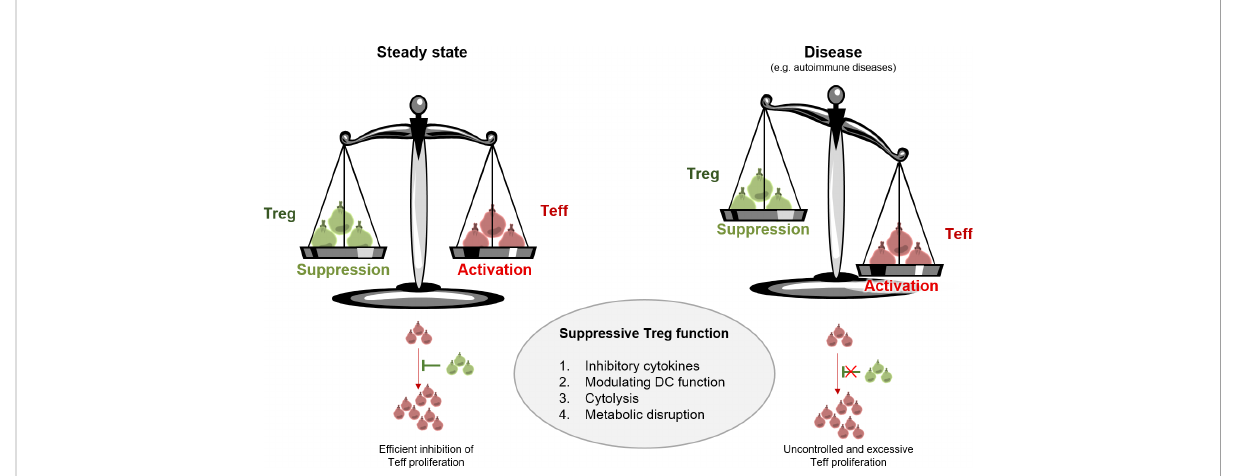
FIGURE 1 Treg function in steady state versus disease. Treg are active mediators of peripheral tolerance and protect us from excessive immune responses including autoimmunity. Treg maintain homeostasis mainly through four modes of action: 1. inhibitory cytokine production, 2. modulating DC function, 3. cytolysis, and 4. metabolic disruption. Aberrant Treg function results in disturbance of immune homeostasis and uncontrolled proliferation of